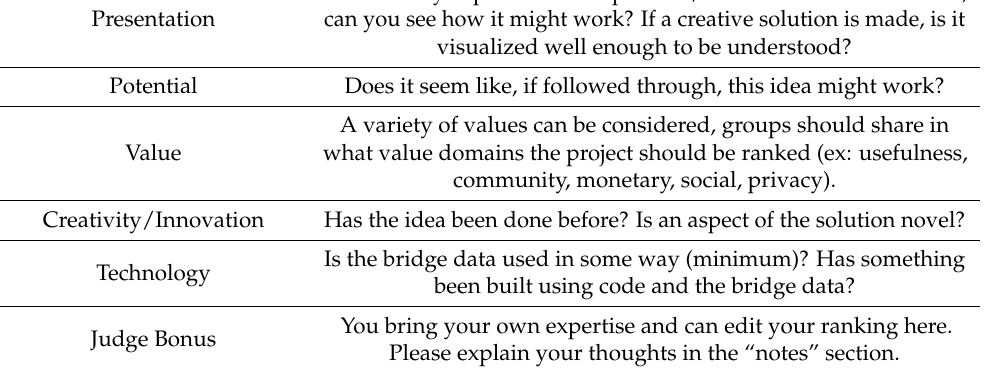
Figure 6. Mind Map (adapted from the event). Table 2. Datathon Judging Criteria.